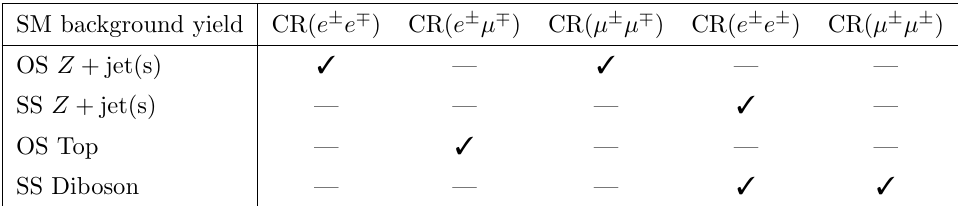
Table 4 . Summary of the control regions used to (cid:12)t the yields of the dominant SM background predictions. CRs used to (cid:12)t a certain SM prediction yield are marked with a check-mark ( 3 ) and CRs not used for this SM prediction are marked with a dash (|).